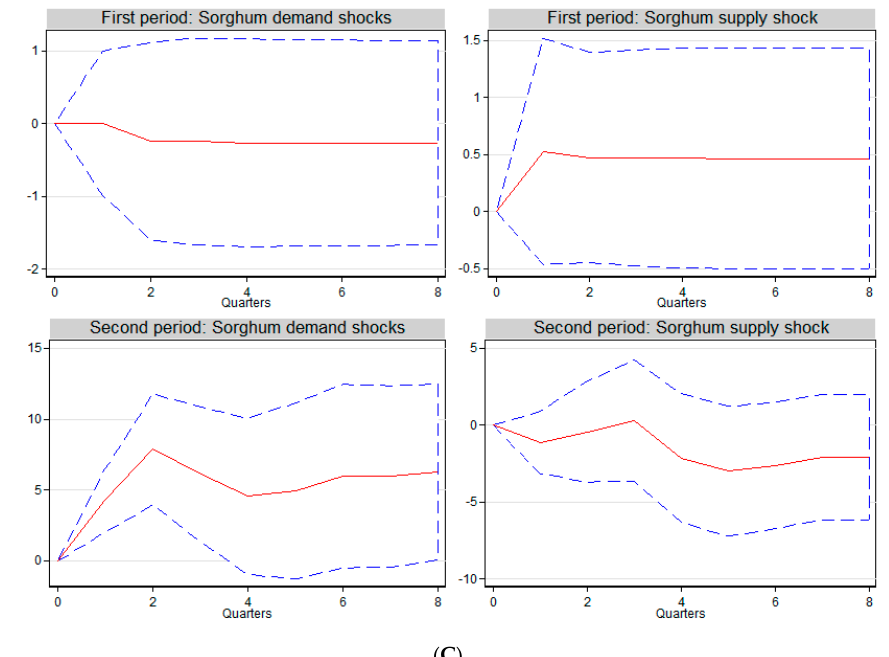
Figure 3. ( A ) Response of oil price to barley supply and demand shocks. ( B ) Response of oil price to corn supply and demand shocks. ( C ) Response of oil price to sorghum supply and demand shocks. Notes: Red lines represent cumulative orthogonalized impulse–response functions while blue lines represent 95% confidence intervals .